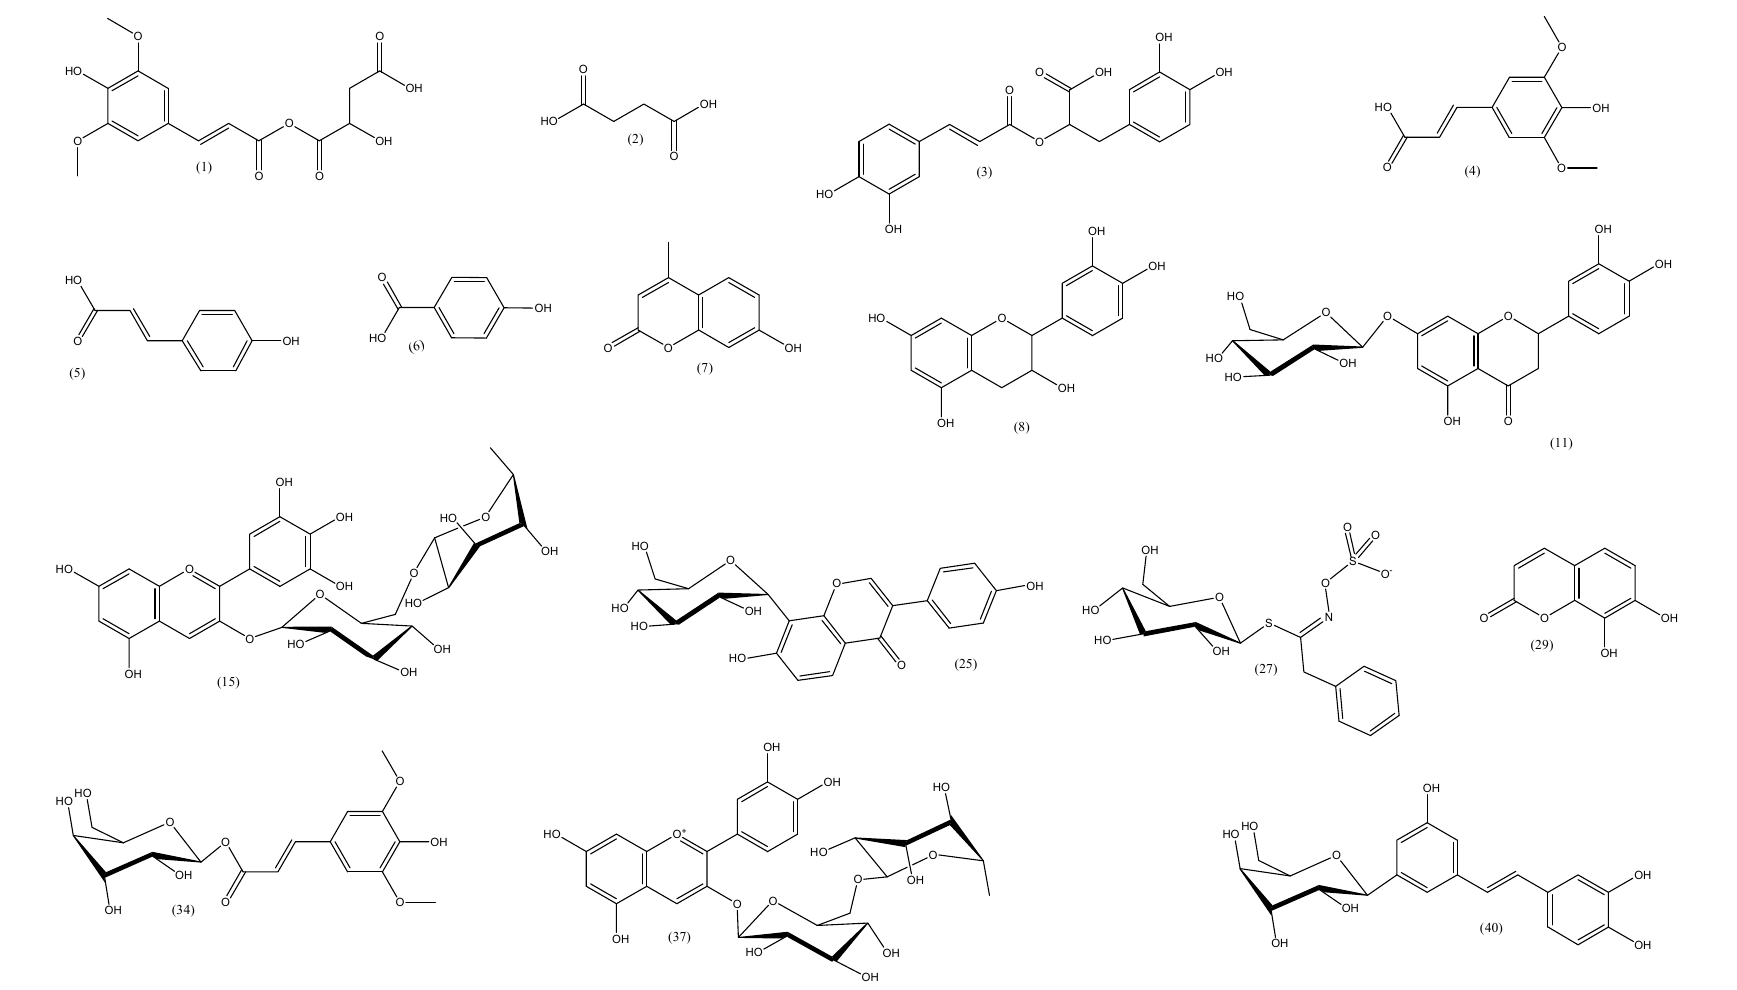
Figure 1. Compounds tentatively identified by UHPLC/QTOF–MS of S. sieboldii extract .